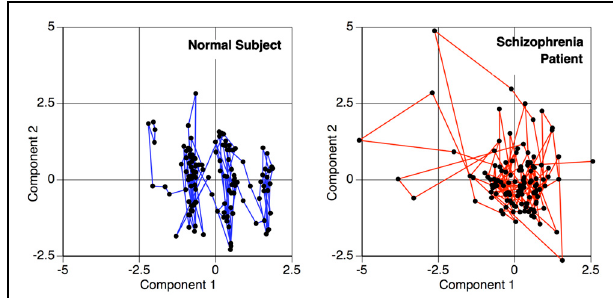
FIGURE 3 | Temporal activity plot of two primary components within a subject, depicting the relationship between two components over time. This phase space transition between pairs of components are measured for the functional connectivity analysis, to calculate the similarity of the components’ behavior.